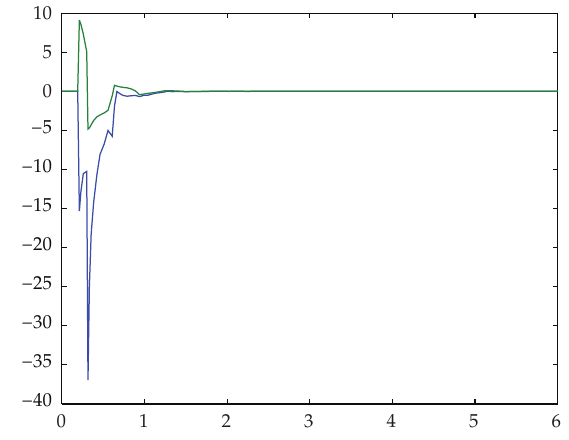
Figure 3: The state response with asynchronous